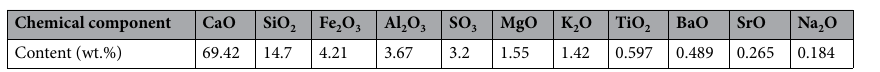
Chemical component Content Table 1. Chemical composition of the cement.